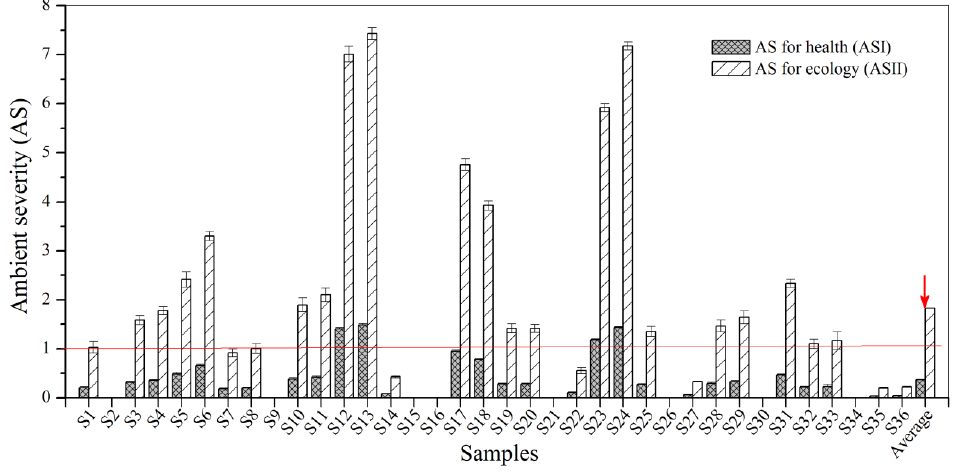
Figure 3. The AS for BBP in the urban sewage samples.